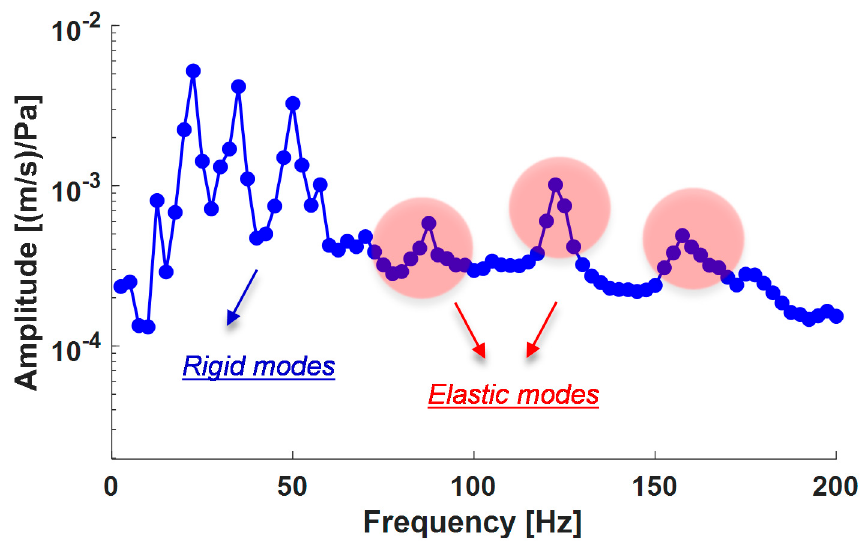
Figure 10. Frequency response function, laser vibrometry.